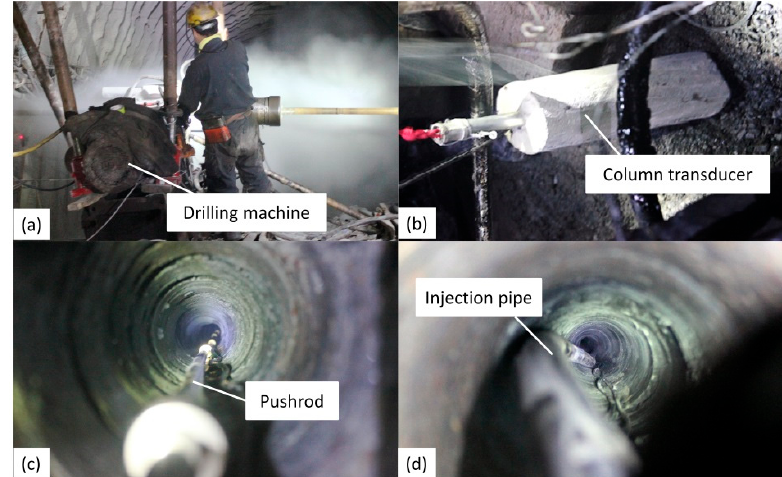
Figure 10. Test process for the RSR method in the PDS No. 1 coal mine: ( a ) Drilling the hole;